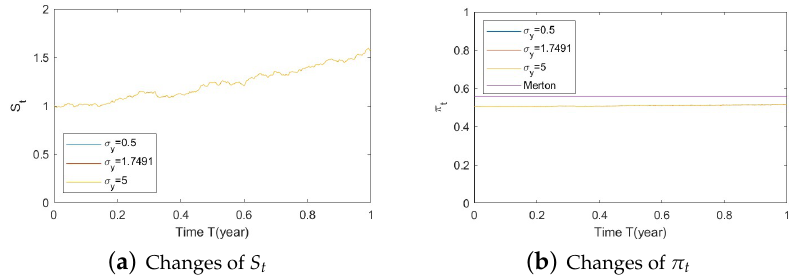
Figure A30. Illustrate the impact on ( a ) stock prices and ( b ) optimal stock allocations when varying σ y ( e . g ., σ y = 0.5,1.7491,5 ) .